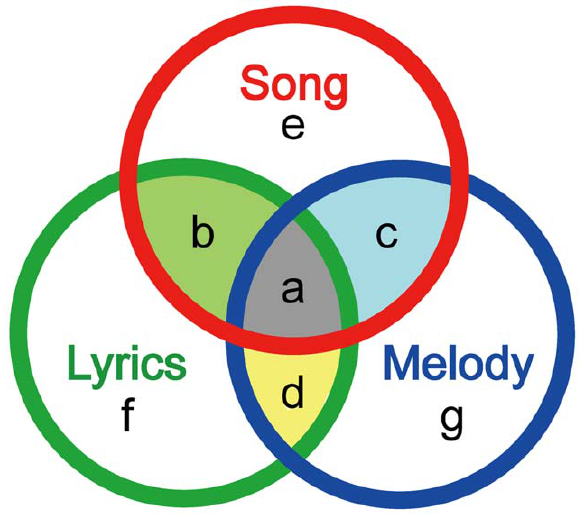
Figure 2. Activations observed under the contrasts (each familiarity decision task compared to the Control task) were categorized mainly into seven processes by conjunction analyses, a: common to all three, b: common to Song and Lyrics, c: common to Song and Melody, d: common to Lyrics and Melody, e: specific for Song, f: specific for Lyrics, and g: specific for